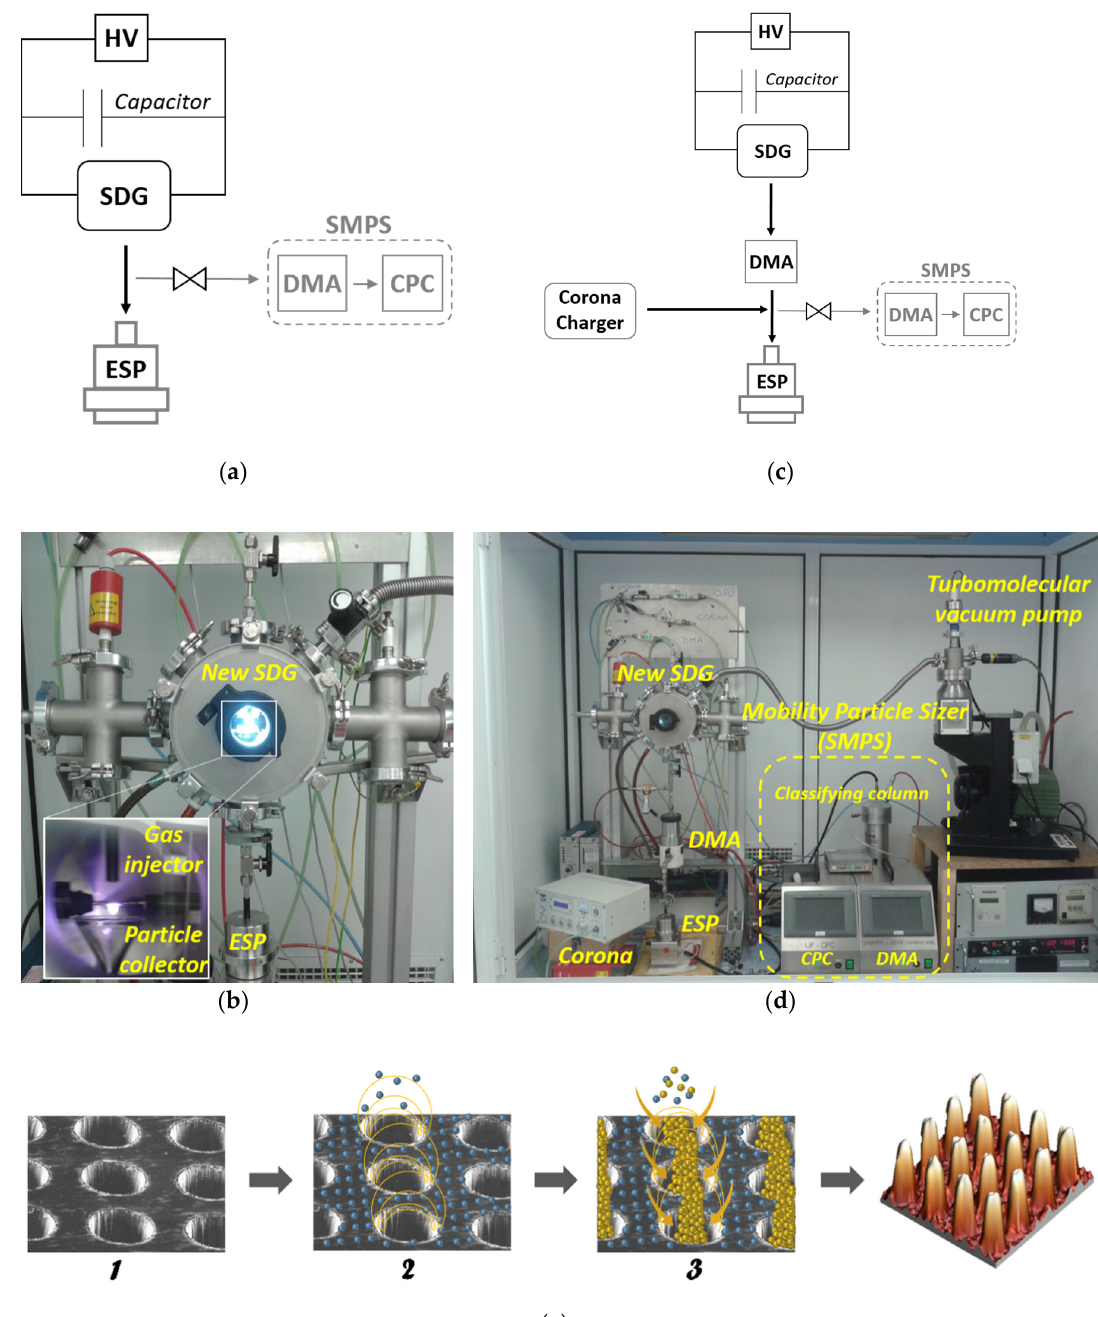
Figure 2. ( a ) Scheme and ( b ) experimental setup for SPNPs and non-agglomerated NPs manufacture. ( c ) Scheme and ( d ) experimental setup for Experimental setup for ENSs production, including the particle measurement system. ( e ) Scheme for a nanoparticulated 3D assembly through the new SDG.